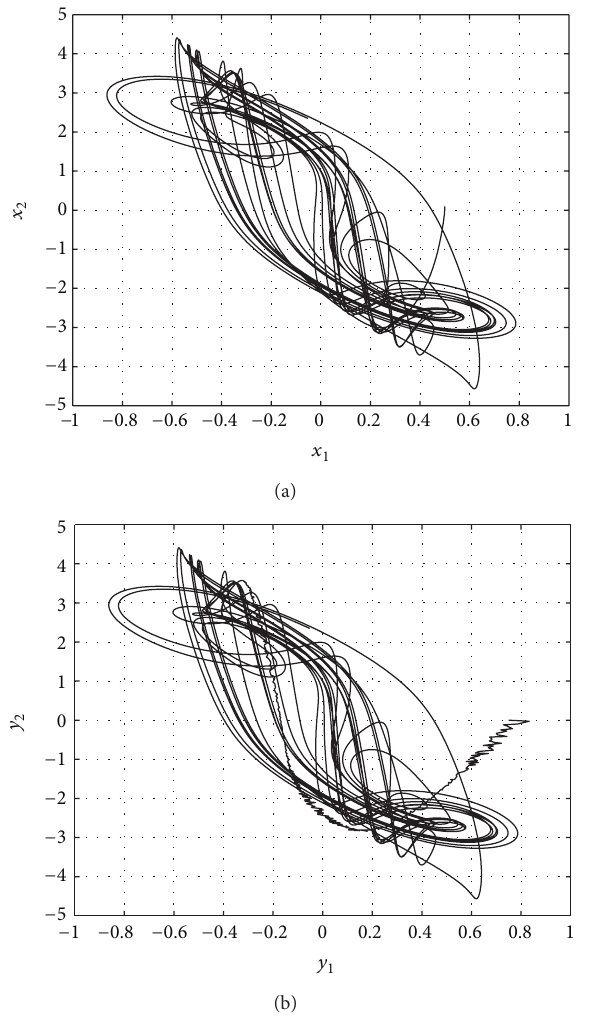
Figure 1: Phase trajectories of drive (a) and response (b) system. Figure 2: State trajectories of drive